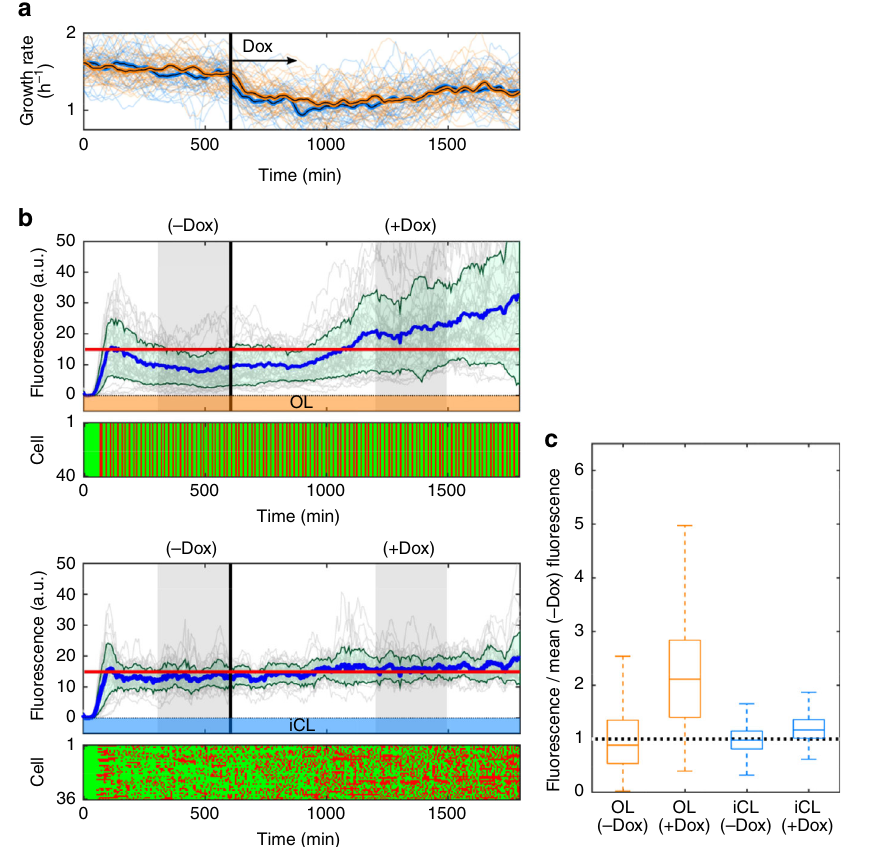
Fig. 4 iCL control maintains low mean and individual errors in a population perturbed with antibiotic. a Growth rates (individual: light lines; mean: dark lines) of cells under open loop (OL) control (orange, n = 40 cells), and individual closed loop (iCL) control (light blue, n = 36 cells). Growth slows after 0.6 μ g ml − 1 doxycycline is added to the culture media at 600 min (vertical line). OL and iCL data are acquired simultaneously from equal numbers of cells initialized per fi eld of view to maximize environmental correspondence. b Individual and mean CFP fl uorescence trajectories (gray, blue lines respectively; green shaded regions = mean ± 1 s.d.) of cells tracking a constant target (15 a.u.) under OL control (upper panel) or iCL control (lower panel). Light stimulation sequences are displayed below the fl uorescence plots. c Relative perturbation of pre-antibiotic CFP fl uorescence levels (measured in − Dox shaded region in b ) by doxycycline (measured in +Dox shaded region in b ), displayed as box plot distributions for open loop (OL, orange) or individual closed loop (iCL, blue) controlled cells. To assess the sensitivity of OL and iCL control to the perturbation, data are normalized, per controller, to mean fl uorescence levels within a 5-h interval immediately prior to doxycycline exposure ( − Dox, shaded region in b ), for comparison to a second interval (+Dox, shaded region in b ) between 10 and 15 h after doxycycline